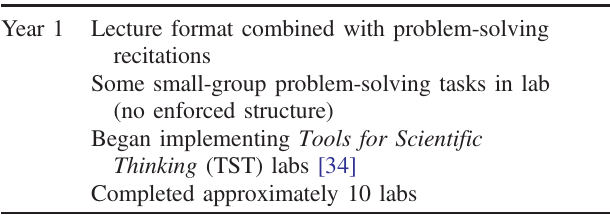
TABLE VII. Changes that were made each year to the general physics course at school